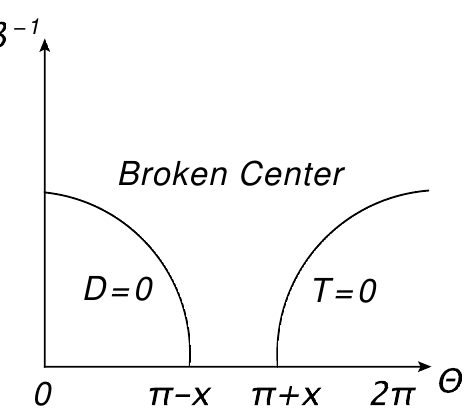
Figure 9 . A possible phase diagram for SU(2) gauge theories. The second order deconfinement line touches the zero temperature line at θ = π x . The low energy 4d theory at zero temperature ± with θ ( π x, π + x ) consists of a free photon. In the special case of x = 0 there is a single ∈ − transition at zero